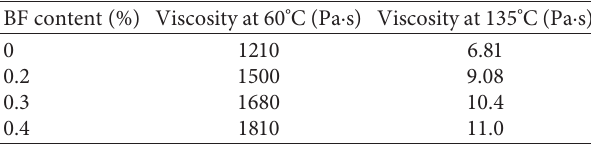
Figure 5: Cone penetration shear test. (a) Sketch of the cone head. (b) Instrument and sample. Table 4: Viscosity of CR-BF asphalt binder at 60 ° C and 135 °